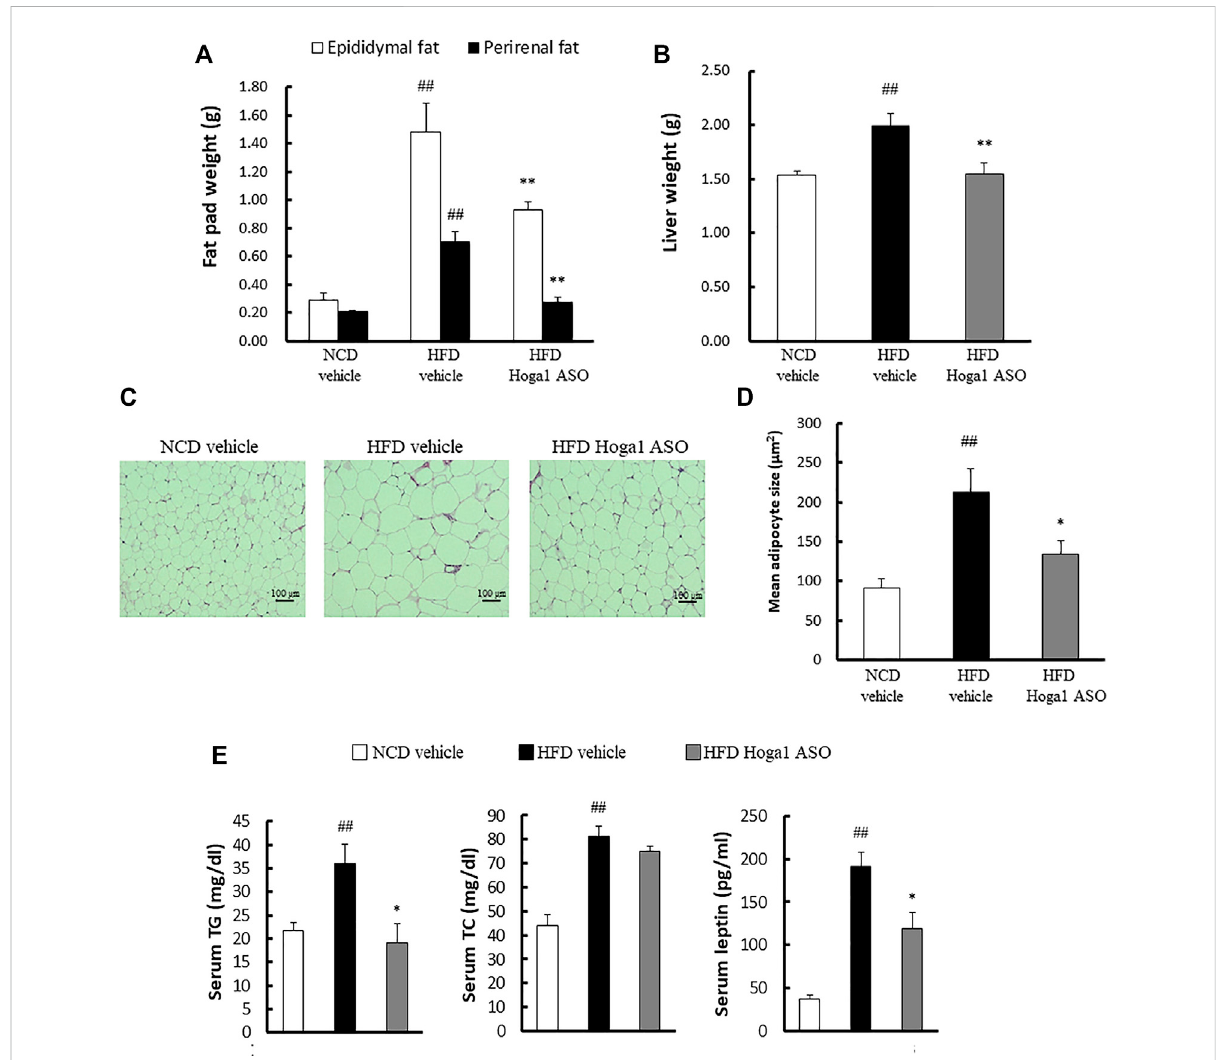
FIGURE 6 The effect of Hoga1 knockdown on lipid properties in obese mice. Fat pad (A) and liver (B) masses of C57BL/6J mice from NCD or HFD mice treatedwithscrambledcontrolASOor Hoga1 ASOweremeasuredfromsixmicepergroup. (C) RepresentativeimagesofH&E-stainedsectionsfrom eWATofNCDorHFDmicetreatedwithscrambledcontrolASOor Hoga1 ASO(×200magni fi cation). (D) Averageadipocytesizepermicroscopic fi eld wascomparedamongtheNCDvehicle,HFDvehicle,andHFDHoga1ASOgroups(N=6pergroup). (E) Triglyceride,totalcholesterol,andleptin levelsofNCDandHFDmicetreatedwithscrambledcontrolASOor Hoga1 ASOweremeasuredfromsixmicepergroup.Resultsareexpressedasthe mean ± SD of three independentexperiments ( ## p < 0.01 indicates asigni fi cant difference between theNCD vehicle and HFD vehicle; * p < 0.05 and ** p < 0.01 indicate signi fi cant differences between the HFD vehicle and HFD Hoga1 ASO,